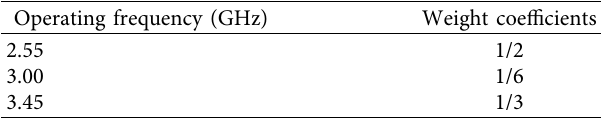
Figure 5: A configuration of the mesh reflector after node reduction. Table 1: The weight coefficients of different operating frequency